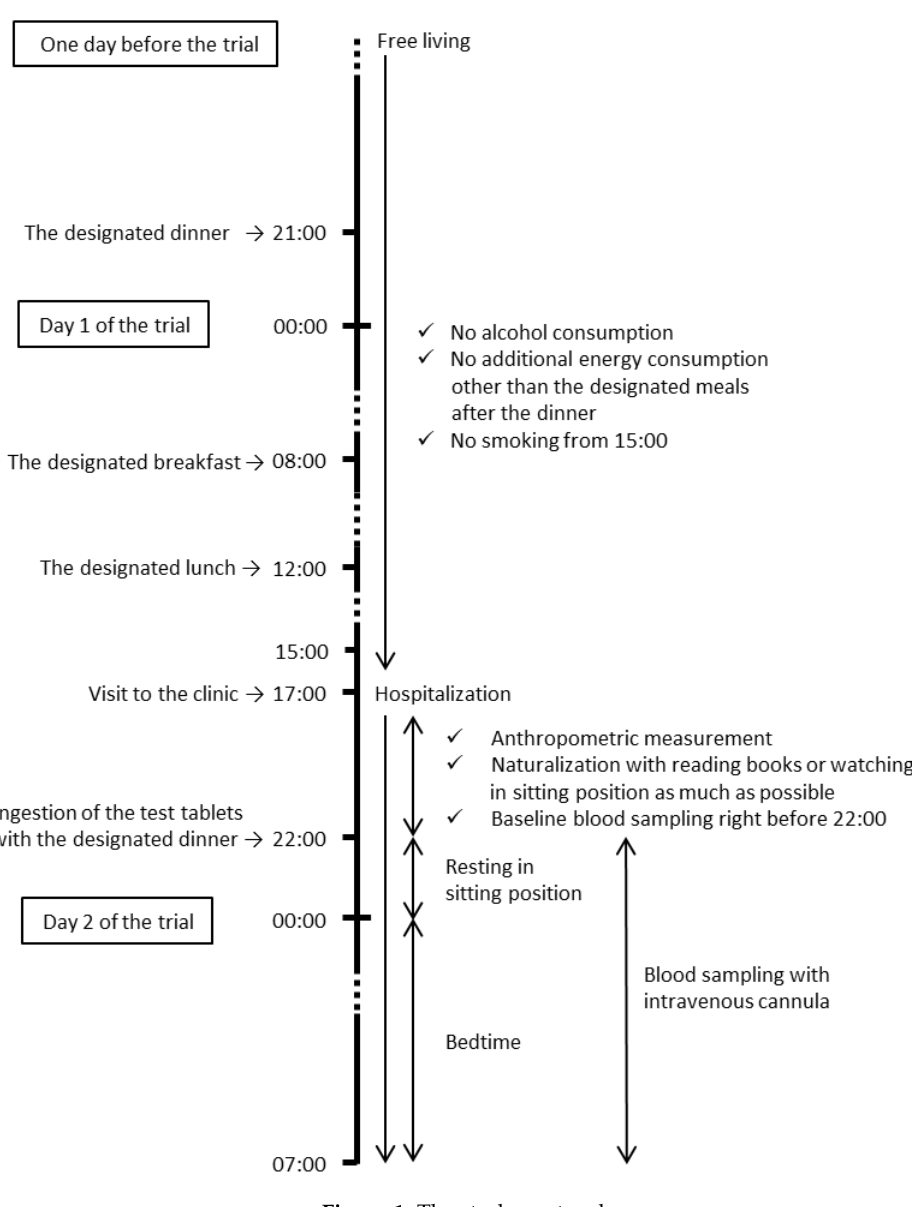
Figure 1. The study protocol.